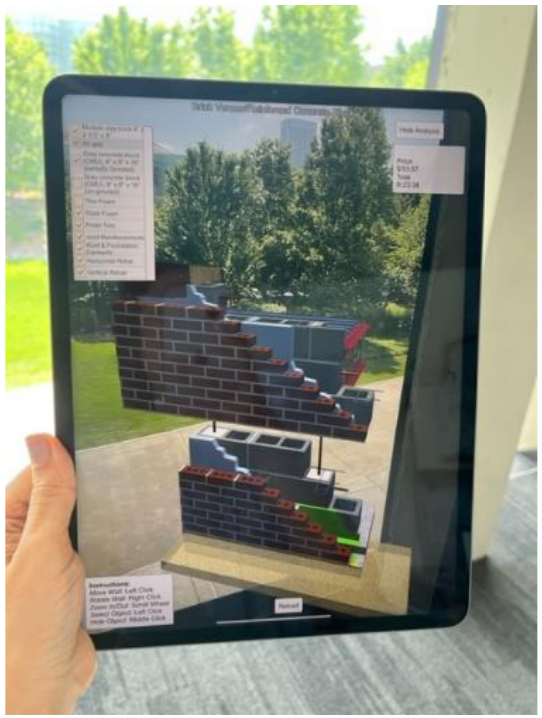
Figure 1. 2D-display AR application created and used by the